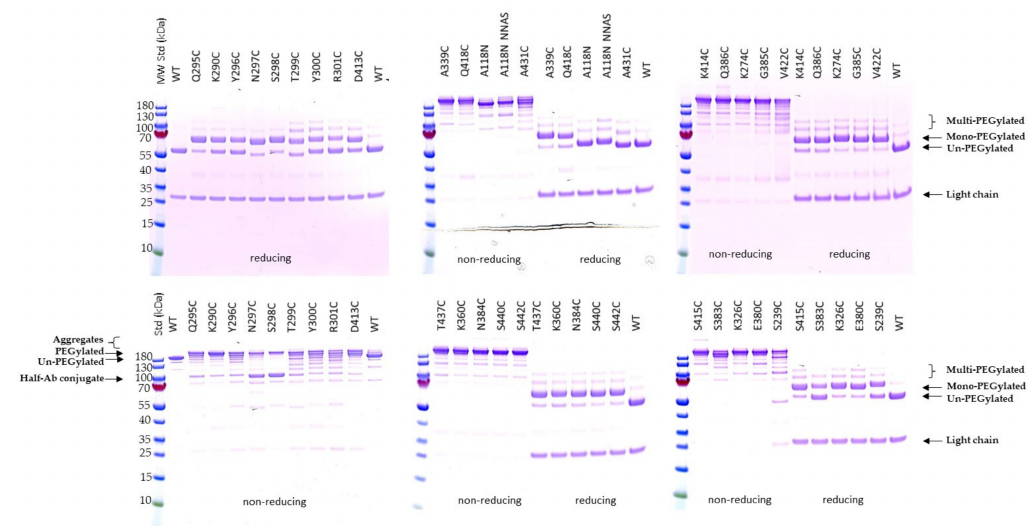
Figure 2. SDS-PAGE analysis of PEGylated single cysteine mutants. 27 unpaired single cysteine mutants were PEGylated and applied to 4–12% Bis-Tris NuPAGE under non-reducing and reducing conditions. The gels were stained with Coomassie blue. The wild-type antibody as well as hyperglycosylated mutants, A118N and A118N NNAS (S298N/T299A/Y300S), were also run together as controls for different migrations of the antibody mutants [28]. PageRuler prestained protein ladder (different kDa as shown on left of the gels) was used as protein molecular weight standards (MW Std or Std). The labels related to identities of the different species are shown (on the left side of non-reducing gel and on the right side of gels under reducing